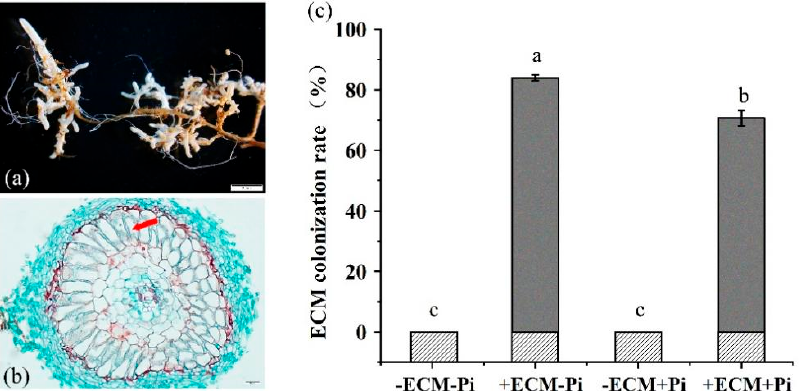
Figure 1. Morphology and anatomy of ECM and root colonization levels of C. henryi seedlings. ( a ) ECM observed by Stereomicroscope (bar scale = 2 mm); ( b ) cross section of ECM. Red arrowhead points to Hartig net (bar scale = 50 µm); ( c ) colonization rate of each treatment in % of the number of root segments colonized by ECMF relative to the total number of the sampled root segments. -ECM-Pi: uninoculated and low Pi; -ECM+Pi: uninoculated and high Pi; +ECM-Pi: inoculated and low Pi; +ECM+Pi: inoculated and high Pi. The error bars indicate standard deviation. Different letters indicate significant differences among treatments ( p < 0.05) according to Duncan’s multiple range test.